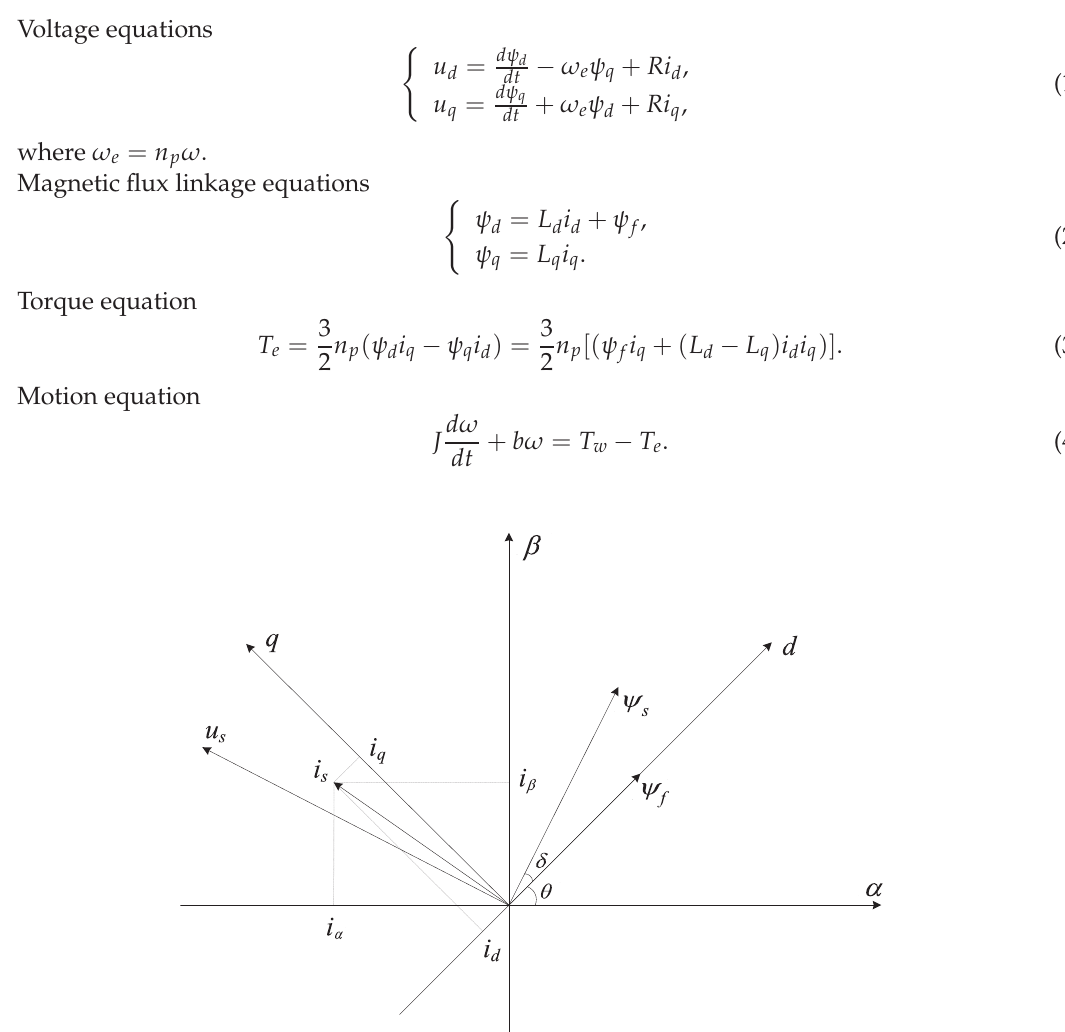
Figure 1. A diagram of the space vector of direct-driven surface-mounted permanent magnet synchronous generator